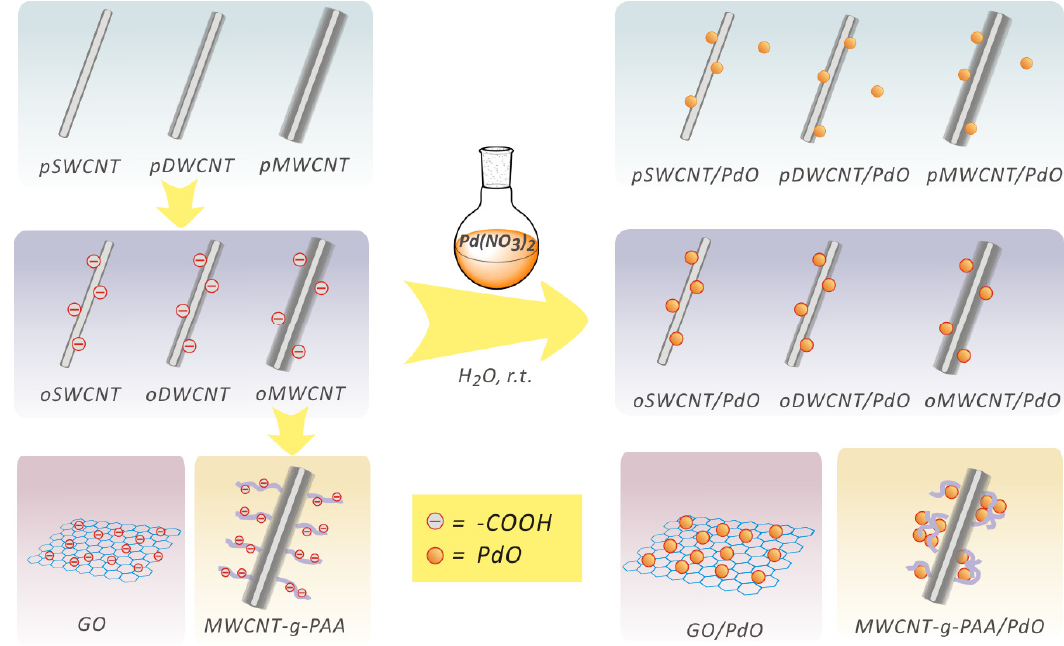
Figure 1. The preparation of CNT/PdO and GO/PdO nanohybrids from Pd(NO solution at room